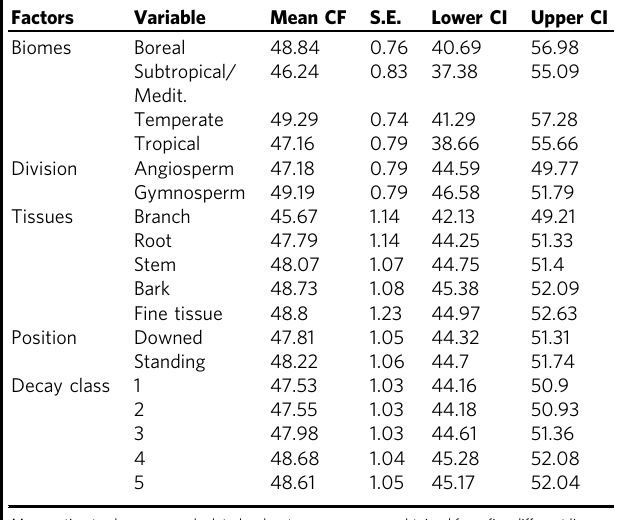
Table 1 Generalized mean dead wood carbon fractions (CF) across fi ve different